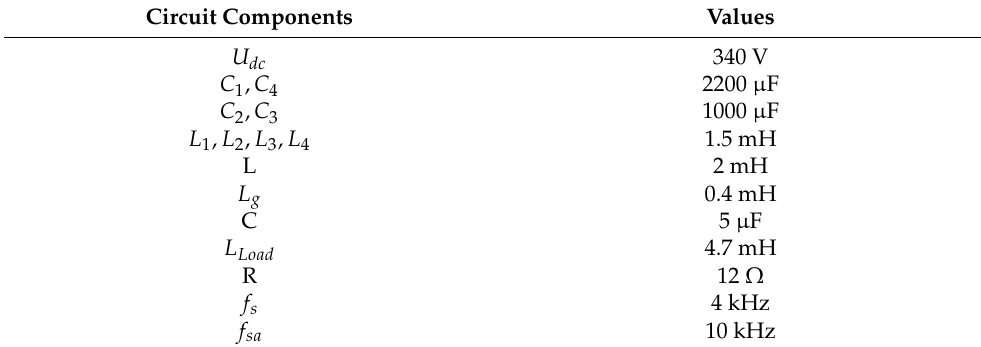
Table 7. Parameters for experiment.